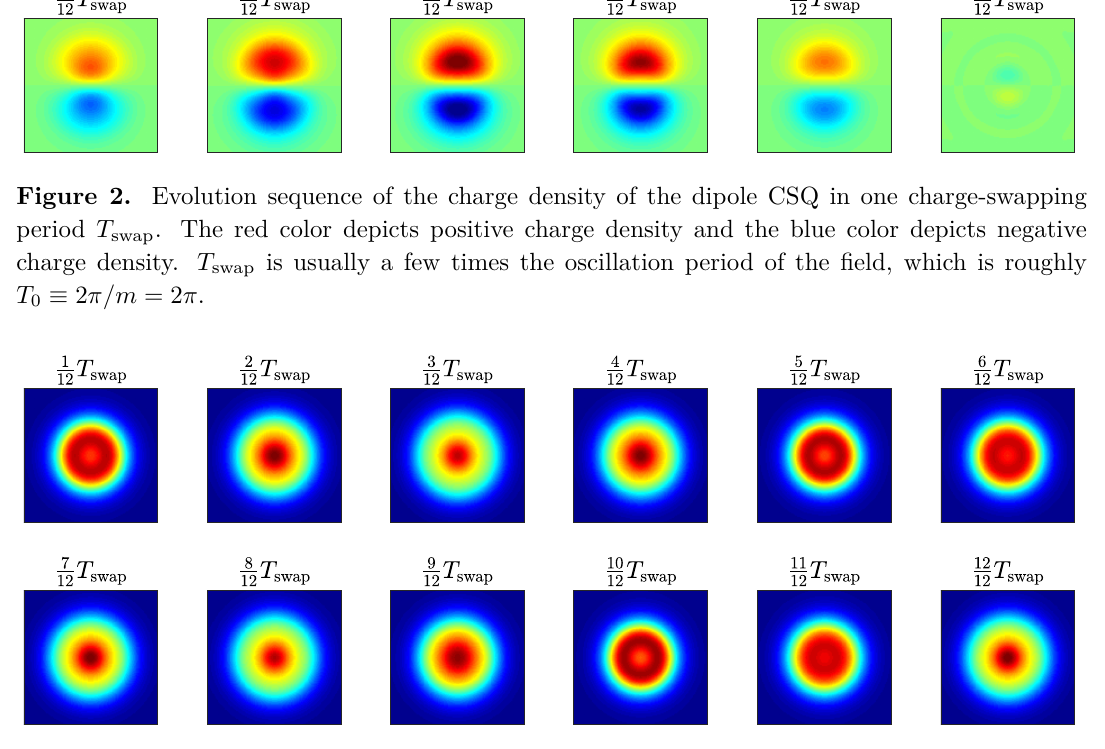
Figure 3. Evolution sequence of the energy density of the dipole CSQ in the same charge-swapping period T as figure 2, with the blue depicting lower density and the red depicting higher density. swap